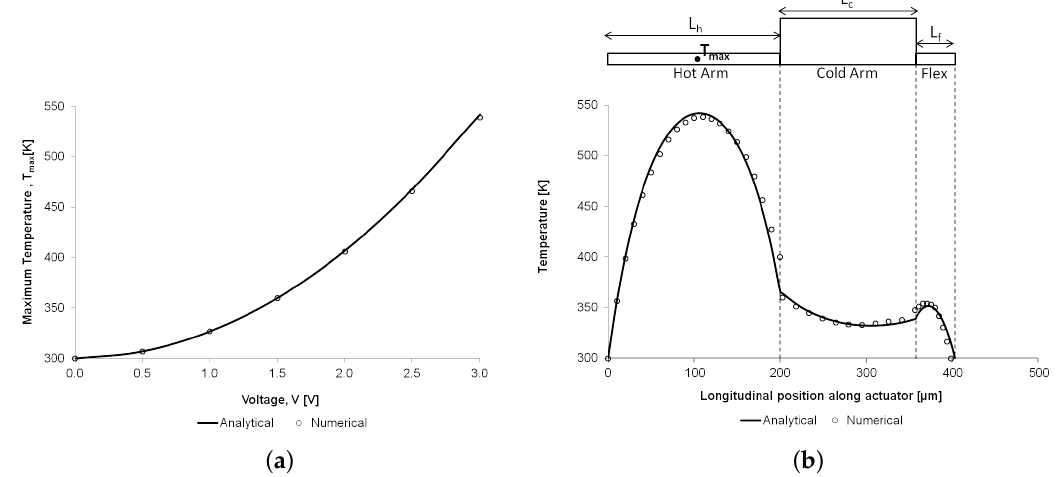
Figure 12. Comparison of the analytical and numerical results for the temperature distribution on the microgripper structure: variation of the maximum temperature on the hot arm as a function of the applied potential ( a ), and temperature profile along the hot arm, cold arm and flexure components at 3 V ( b ). For illustration purposes, the diagram above the graph in ( b ) shows a thermal actuator (without the extending microgripper arms) as if it were unfolded.